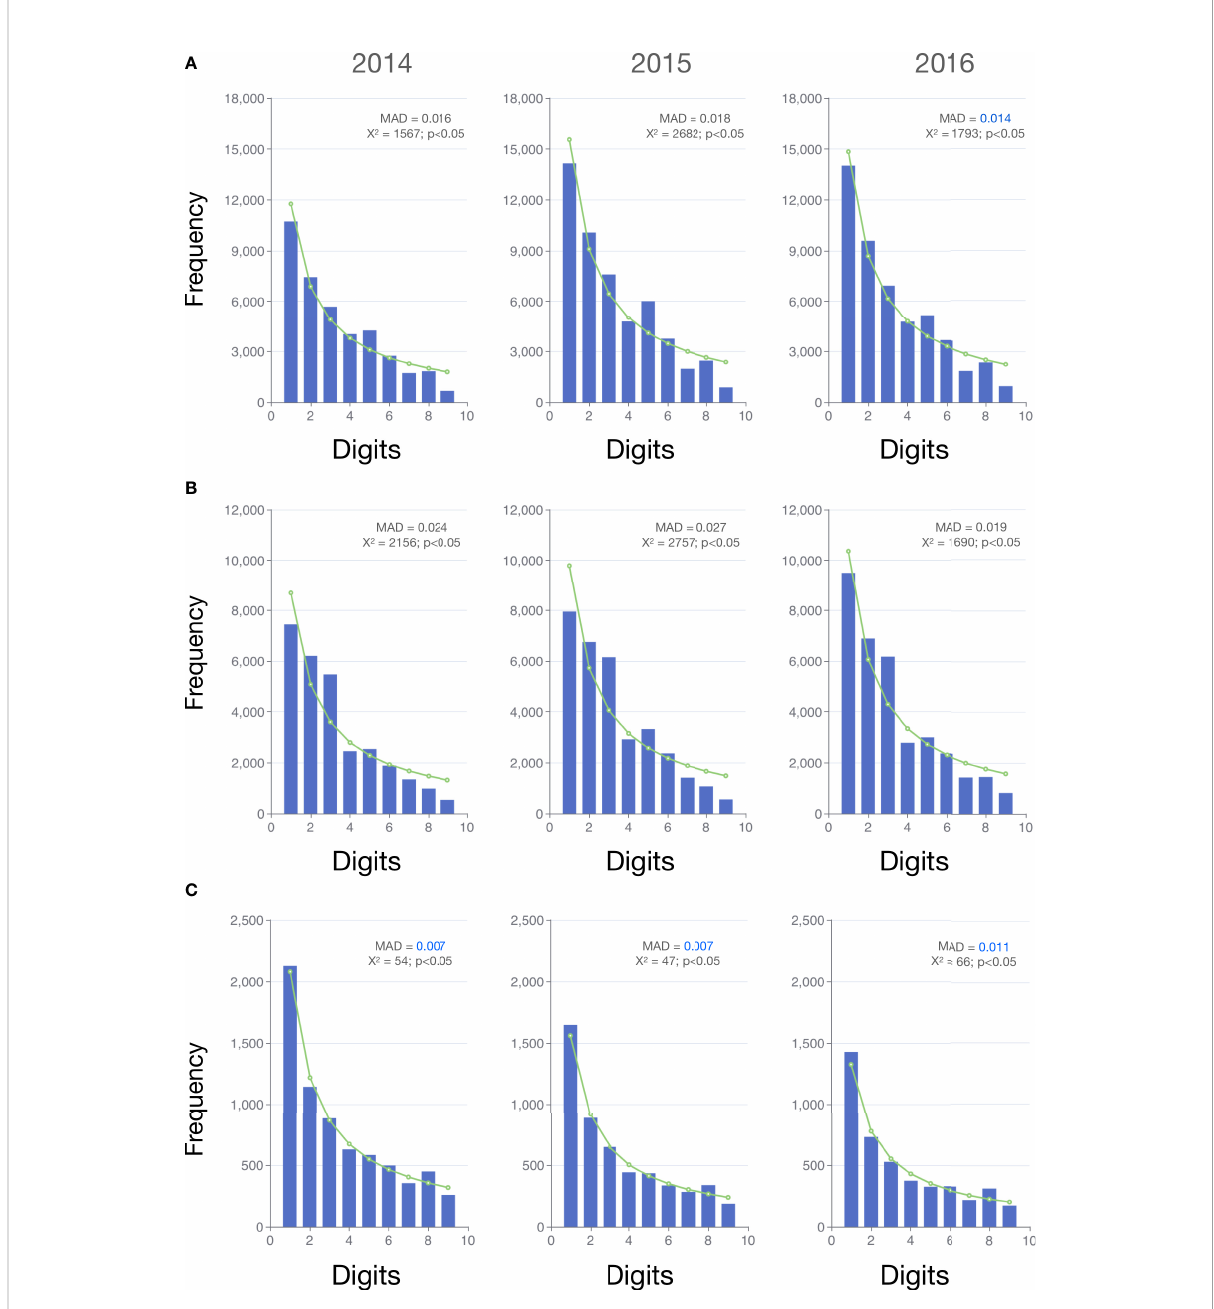
FIGURE 3 Daily frequency distribution of the fi rst digits, for each year, of motorized canoes (A) , non-motorized canoes (B) , and motorized boats (C) (blue bars), and the expected Benford distribution (green line). MAD values higher or equal to 0.015 do not conform with Benford ’ s law (Nigrini,